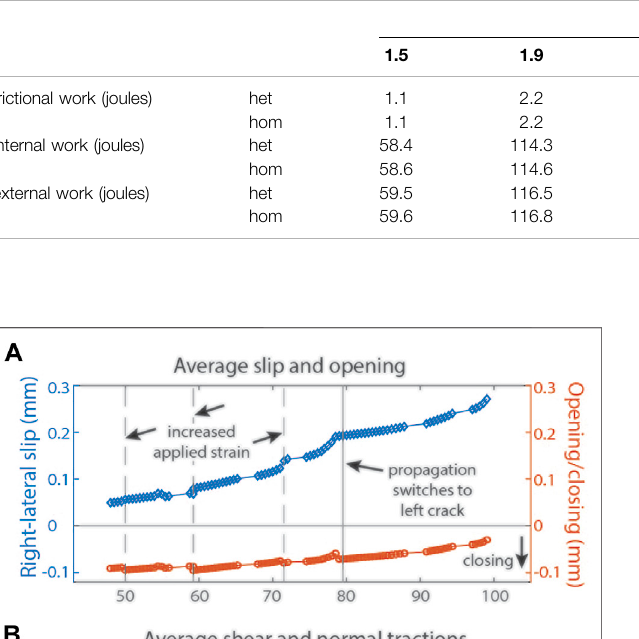
Frontiers in Earth Science |